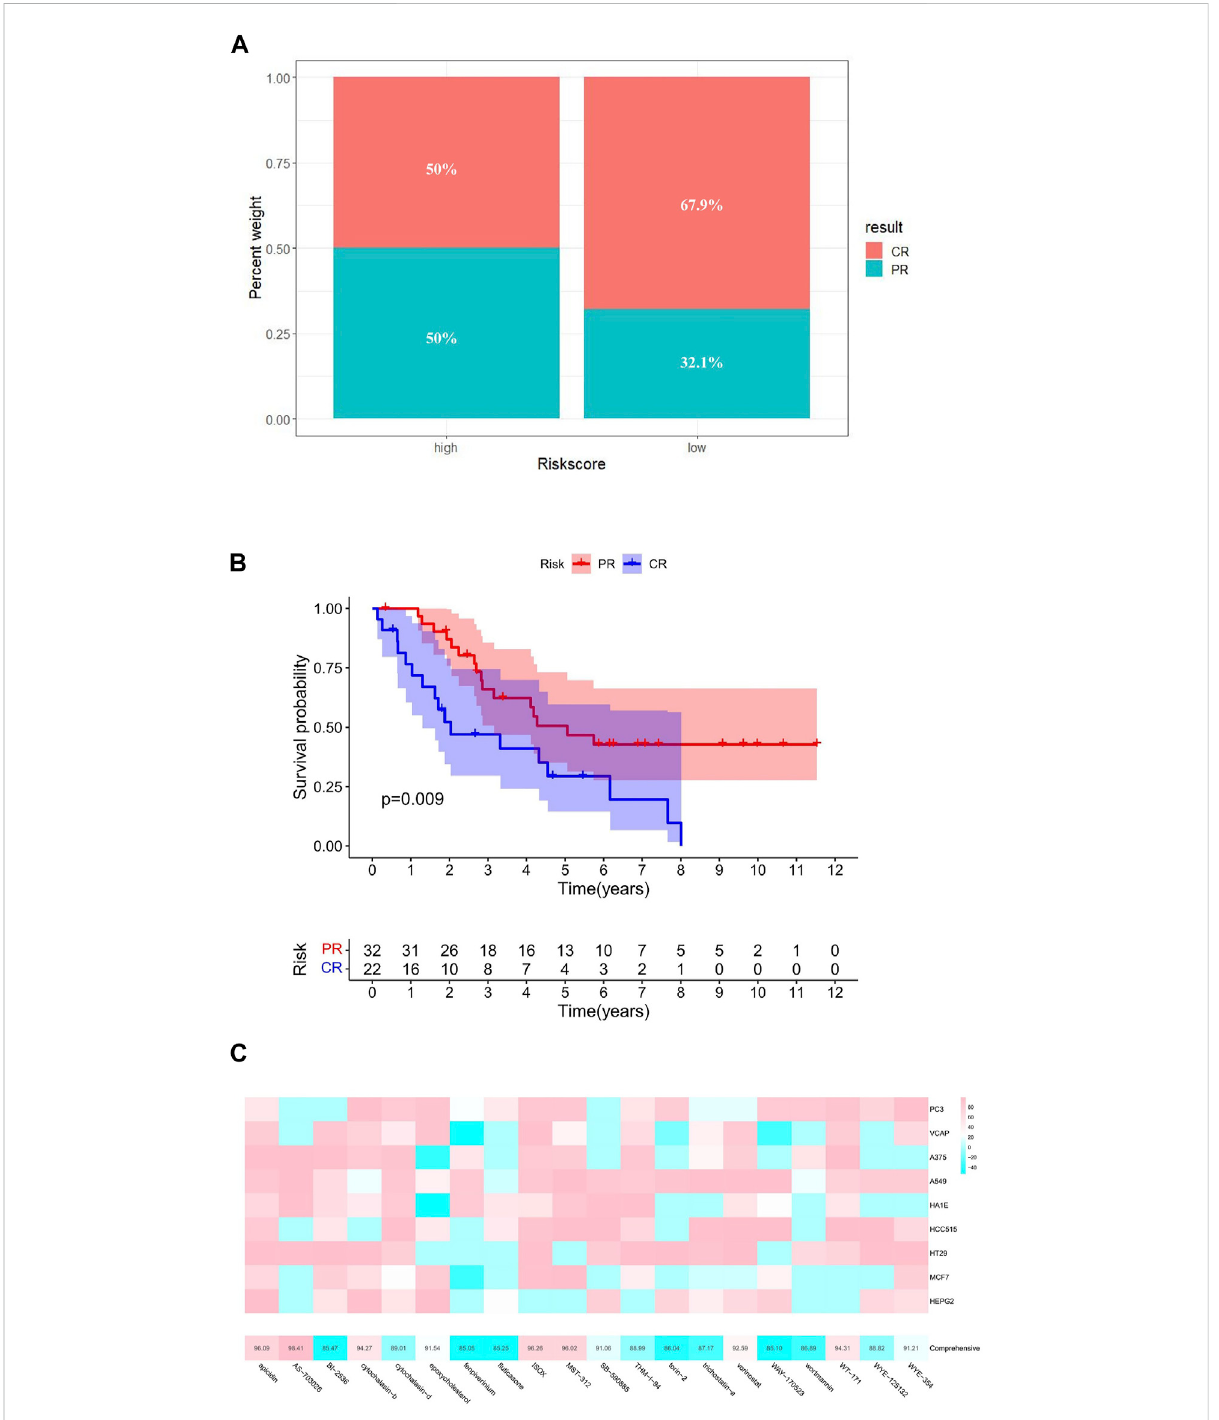
FIGURE 8 Targeted therapy analysis. (A) Ef fi cacy of platinum/paclitaxel in the high- and low-risk groups. (B) Relationship between therapeutic effect and survival. (C) PotentialtargeteddrugspredictedbycMAPanalysis(theabscissaoftheheatmapisthecompoundandscore,theordinateisthecellline, red indicates sensitivity to the compound, and blue indicates insensitivity to the